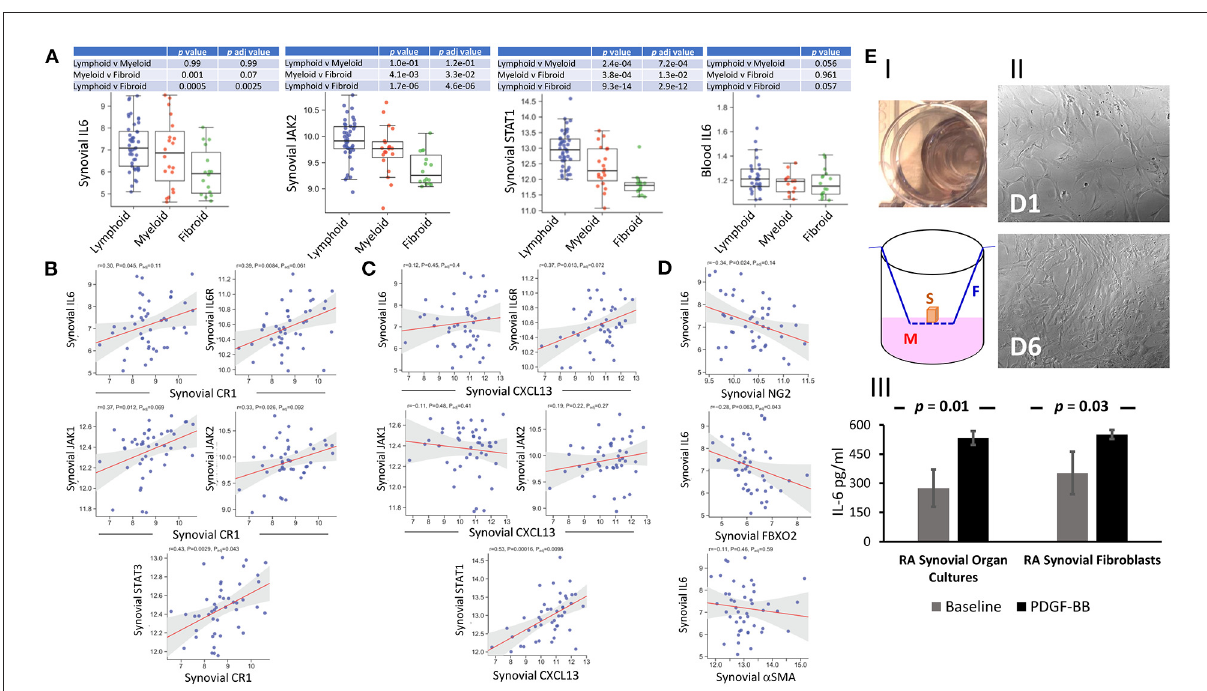
FIGURE8 Correlation of IL-6 expression with synovial pathotypes and FDC markers. (A) Boxplots displaying the correlation of synovial IL-6, JAK2, STAT1, and blood IL-6 expression with synovial pathotypes. (B,C) Correlation blots of synovial IL-6, IL-6R, JAK1, and JAK2 expression with the FDC markers complement receptor 1 (CR1/CD35) and CXCL13, respectively. Correlation of STAT3 and STAT1 with CR1 and CXCL13 respectively are also shown. (D) Correlation of synovial IL-6 expression with the markers associated with early FDC differentiation including NG2 (pericytes), α SMA (myofibroblasts), and FBXO2 (CNA.42). (E) IL-6 release from synovial organ and fibroblast cultures stimulated with 300ng/ml PDGF-BB for 24 hrs and 6 days respectively. (E-I) Synovial organ culture showing a piece of synovial tissue placed in cell culture inserts mounted in 24-well plates (Upper). Diagrammatic representation of the synovial organ culture setup (S = Synovial Tissue, M = Culture Medium, F = Filter Device). (E-II) Rheumatoid arthritis synovial fibroblasts (RASFs) at base line (Day 1 = D1) and after 6-day (D6) stimulation with PDGF-BB. IL-6 levels at baseline and after stimulation are shown in (E-III) . Cultures were run in triplicates and data is expressed as the mean ± SEM. Significance was calculated using 2-tailed unpaired student T test and the p -value between baseline and PDGF-BB stimulation is